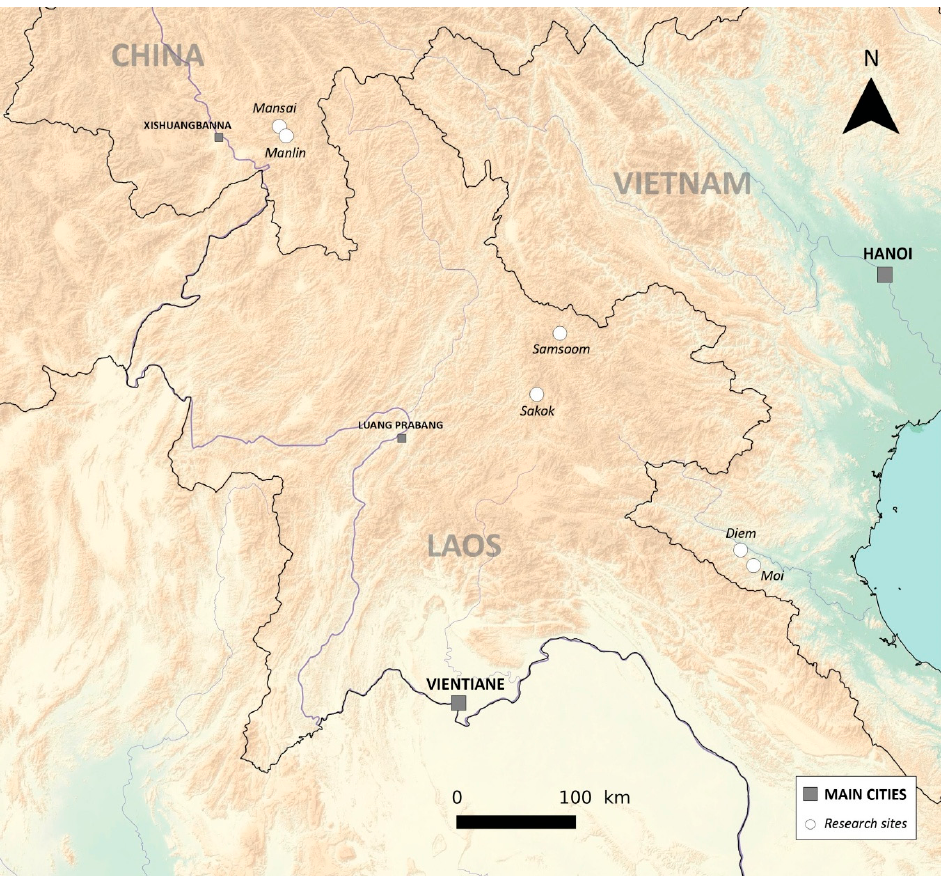
Figure 2. Location of the six villages chosen as research sites. Table 1. Data collection and analysis related to land uses, landscapes and